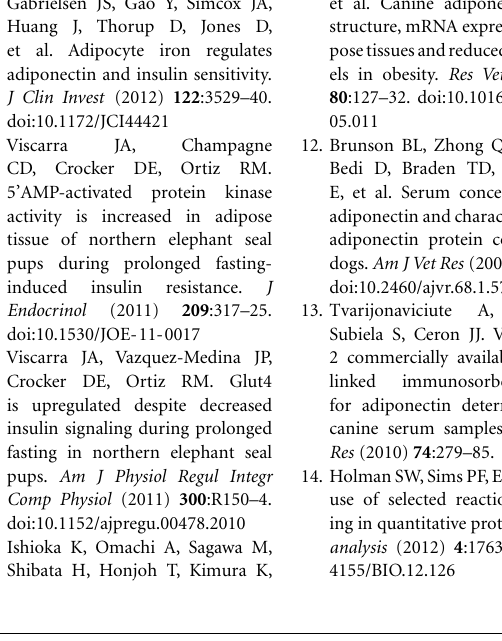
Table S1 | Ion pairs and instrument parameters used for PRM . Each endogenous target peptide had an isotopically labeled synthetic version constructed with either a C-terminal 8Lys or 10Arg, designated by a “ ∧ ” and referred to as heavy. Fragment ion peak areas were extracted from each MS/MS experiment using these monoisotopic masses ± 0.05 m/z . Table S2 | Complete hematologic and serum biochemistry data of study group . AWilcoxon rank-sum test was used to compare blood chemistry values between groups. Table S3 |Assay performance measures .To evaluate assay performance on the days of analysis, experimental triplicates were used quantify assay variability and detection limits.The average peak area ratio was determined based on all samples analyzed. Table S4 | Measured adiponectin concentrations in blood from different organisms using different techniques . Reported adiponectin measurements by ELISA are typically microgram per milliliter therefore concentrations were converted using the molecular weight of adiponectin from each species (an elephant seal was assumed to be exactly